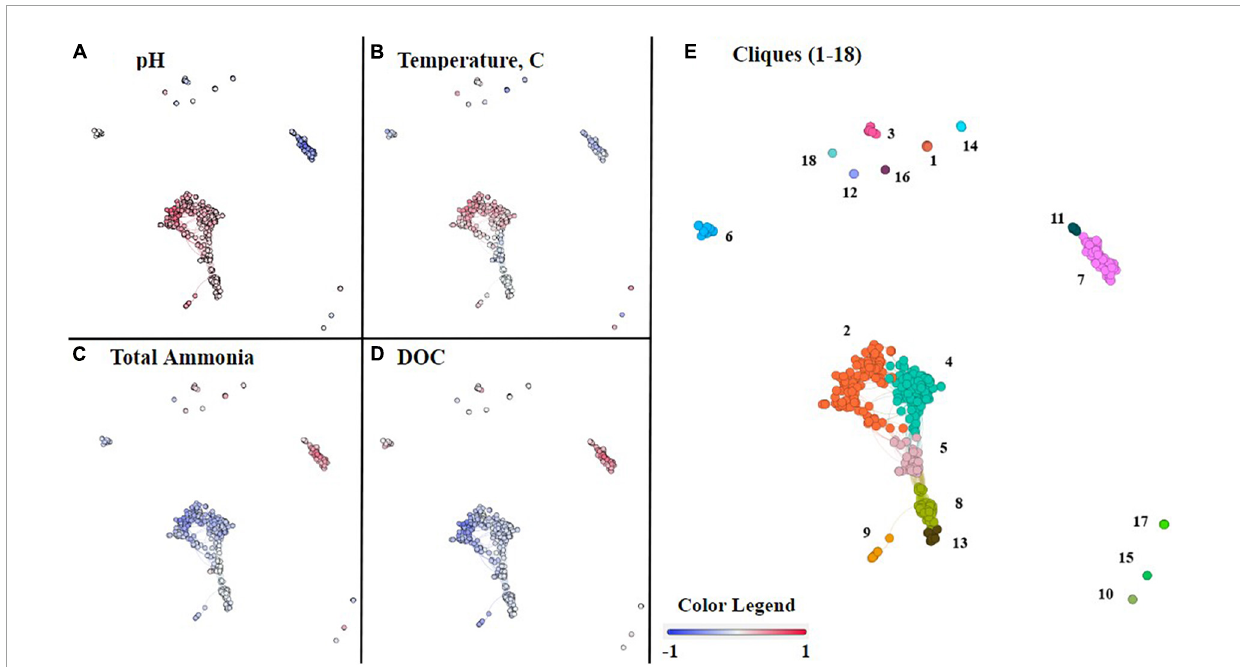
FIGURE5 Co-occurrence network analysis of commonly occurring ASVs within the 46 hot spring samples. Each node represents an ASV, and nodes were organized into 18 cliques using Louvain’s membership algorithm. The connections between nodes, also known as edges, represent a > 0.7 Spearman’s correlation coefficient. In panels (A–D) , each node is colored on a gradient of blue to red based on its Spearman’s correlation, from negative one to positive one, respectively, with the following geochemical parameters, (A) pH, (B) temperature, (C) total ammonia, and (D) DOC. Each of the cliques is differentiated by color and number in panel (E)